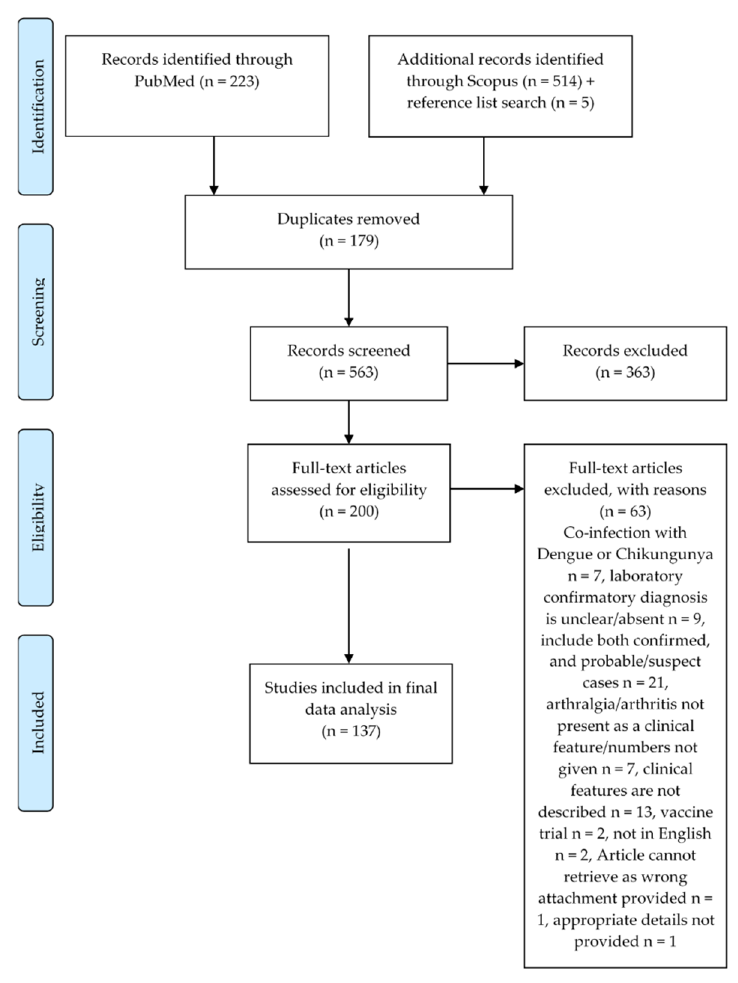
Figure 2. Preferred Reporting Items for Systematic Reviews and Meta-Analyses (PRISMA) flow chart of included studies.